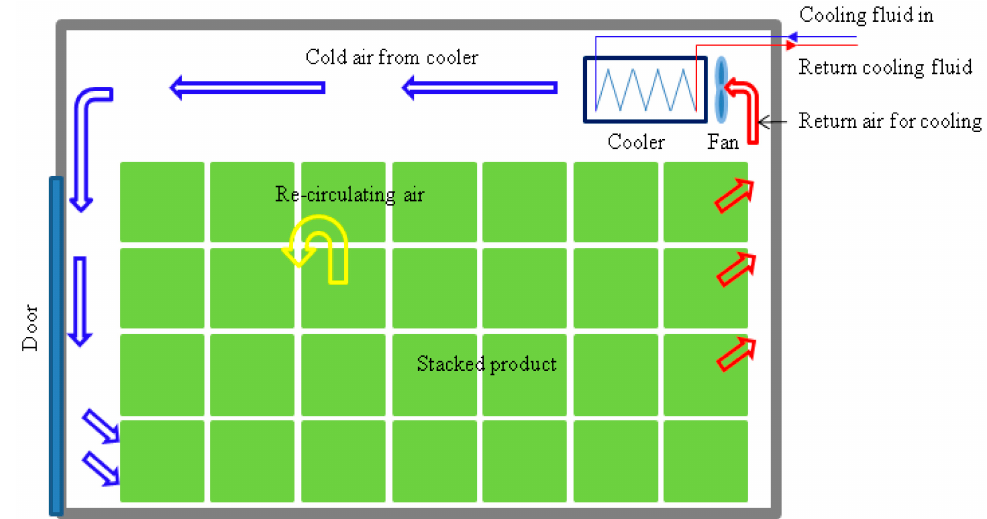
Figure 3. Typical forced-air-cooling schema of horticultural produce [23] (Reprinted with permission from the journal’s editors).